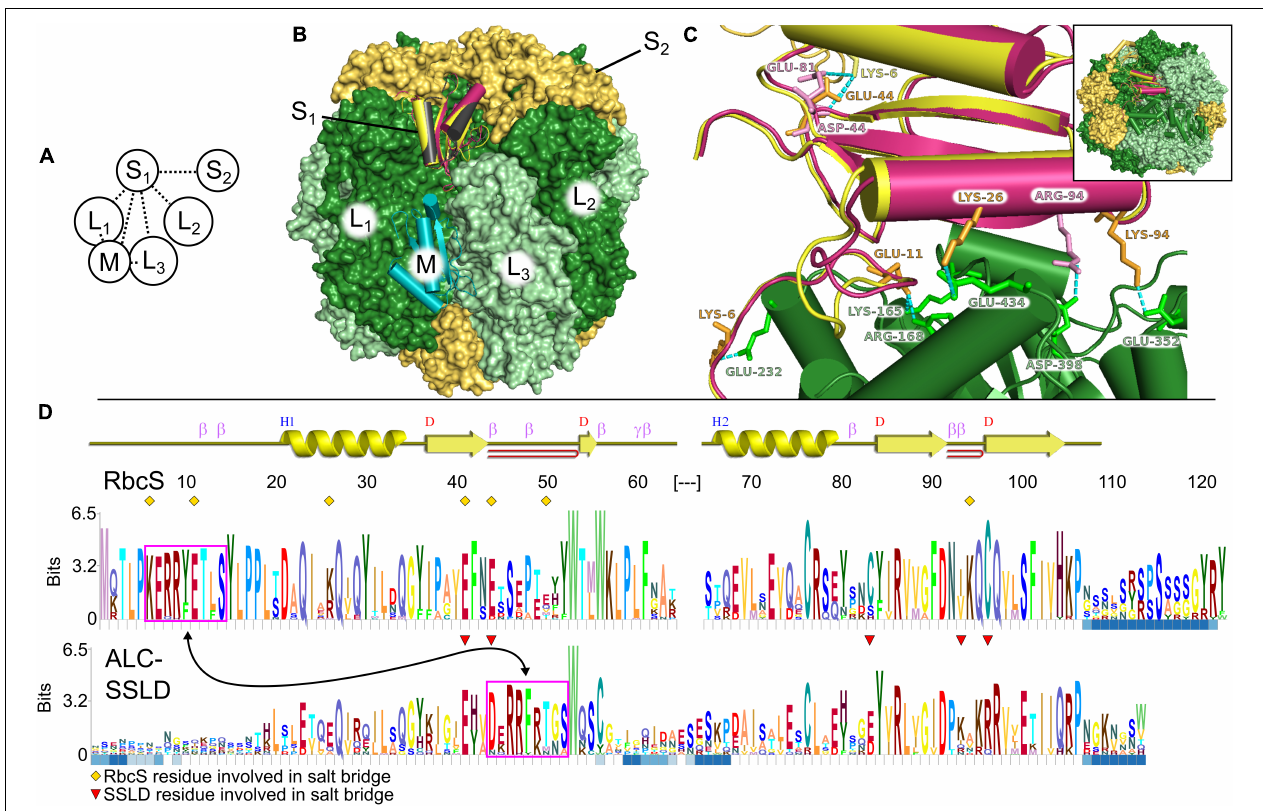
FIGURE 1 | Structural comparison of small subunit of rubisco (RbcS) and small subunit-like domain (SSLD). (A) Schematic diagram of the interactions that a single RbcS (S 1 ) or SSLD (M) has in a rubisco holoenzyme. Numbering based on van Lun et al. (2011). (B) Alignment of the SSLD found in activase-like proteins of cyanobacteria (ALCs) (black is based on an SSLD model, burgundy on an RbcS model) to the RbcS (yellow) or SSLD (teal) binding sites of an L 8 S 8 rubisco holoenzyme. (C) Interaction between the large subunit of rubisco (RbcL 1 ) (green) and RbcS (yellow) or SSLD (burgundy) in the context of the RubisCO holoenzyme. Labeled residues highlight residues predicted to interact in a salt bridge interaction ( Supplementary Table S1 ), with label color based on the subunit it is from. Numbering for the SSLD is based on the trimmed region beginning at residue 317 in the full-length Fd ALC. Dashed cyan lines show the predicted interacting atoms. Inset indicates a zoomed-out view of the holoenzyme. (D) HMM-Logo highlighting the areas of sequence conservation between RbcS and the SSLD of ALC across cyanobacteria containing both. A schematic for the secondary structure of the homology model for RbcS from Fremyella is presented above the two logos. Blue squares below each residue depict regions with gaps in significant portions of the multiple sequence alignment (MSA). Magenta boxes, connected by an arrow, indicate a motif found in both MSAs. Yellow diamonds indicate the RbcS residues involved in salt bridge interactions in the Fremyella homology model, while red triangles indicate ALC-SSLD residues involved in salt bridge interactions in the S1 position in the homology model ( Supplementary Table S1